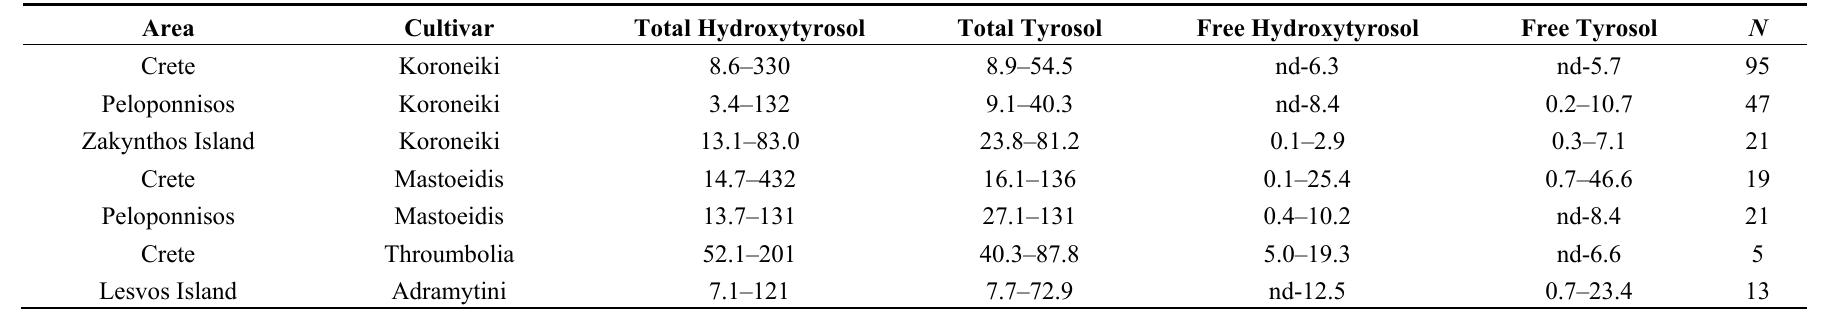
Table 3. Tyrosol and hydroxytyrosol (mg/kg) in Greek monovarietal EVOO obtained during five harvesting periods (2002–2006 & 2007–2008)